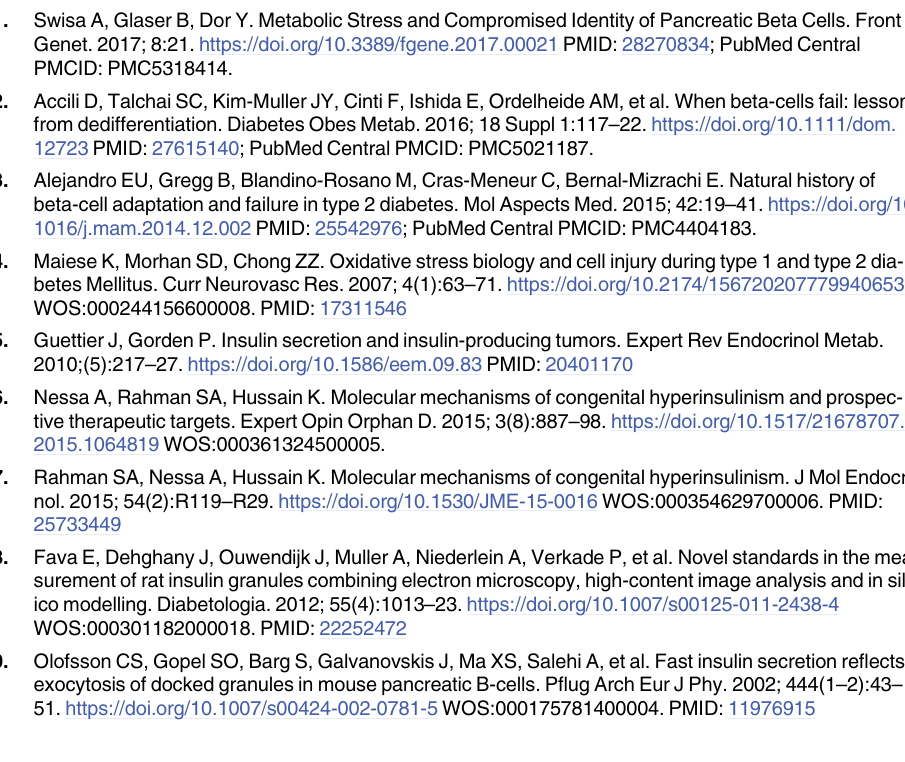
S1 Table. Raw numbers used in quantitative plots in all